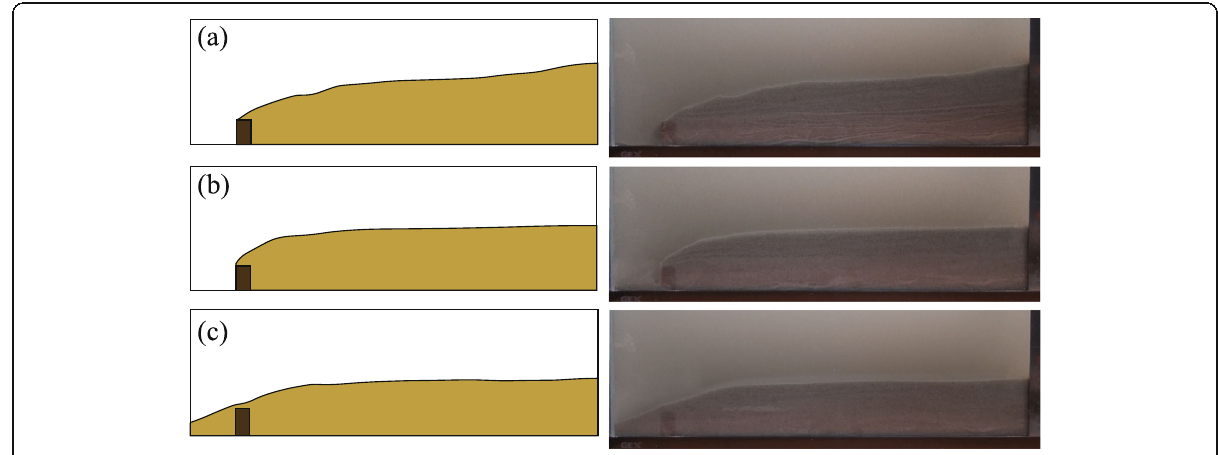
Fig. 3 Single-layer sandbox test; frontal view in illustration (left) and actual image (right) at different stages: a Before excitation, b during liquefaction, and c after mass movement. In the illustration, brown and dark yellow represent the vertical plate and coarse sand,